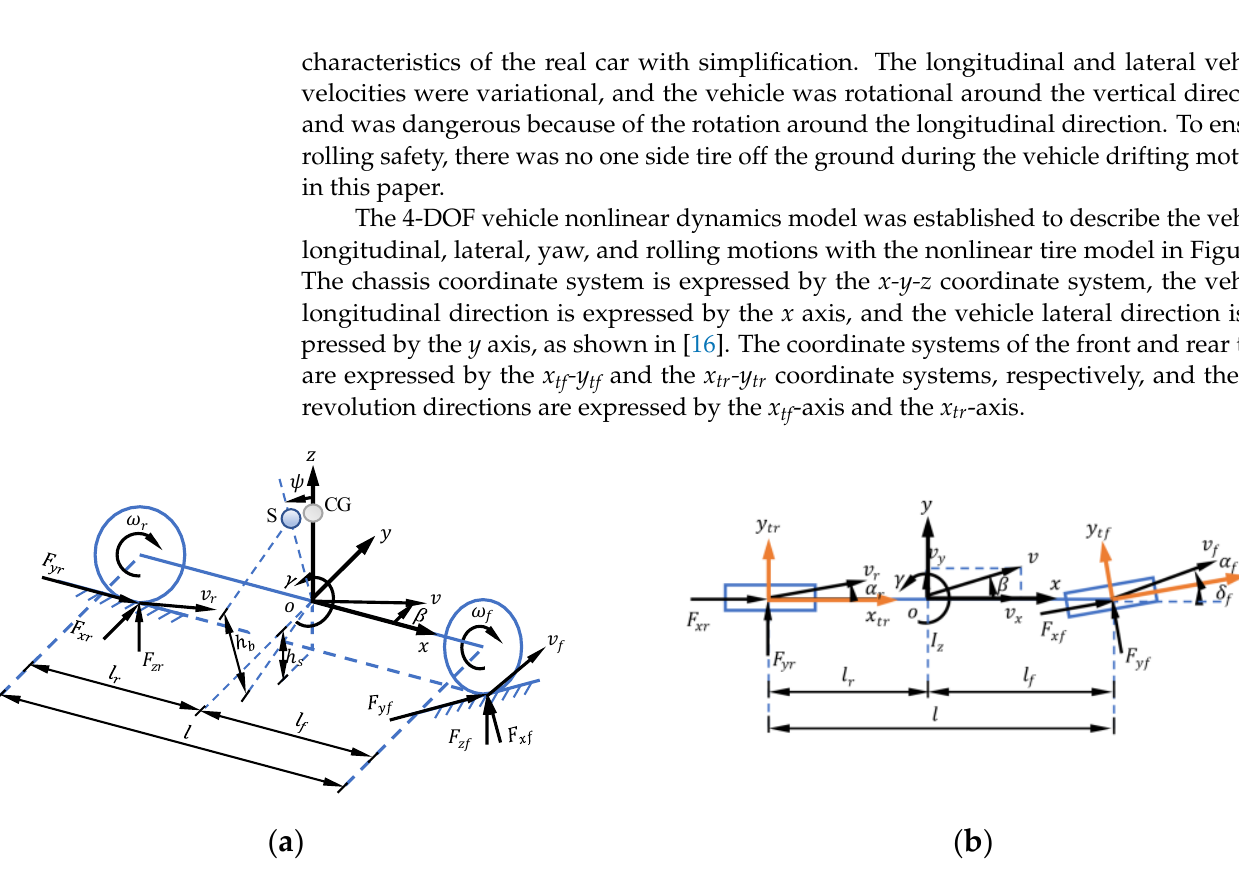
Figure 1. Vehicle dynamics model: ( a ) perspective view; ( b ) plan view. The vehicle dynamics equations are as shown in Equations (1)–(4) to describe vehicle dynamics characteristics in Figure